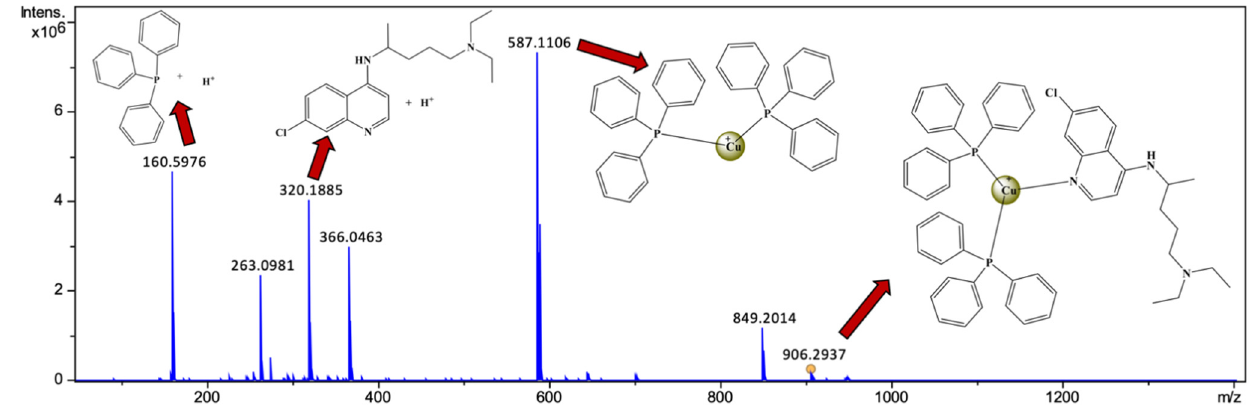
Figure 2. ESI(+)-MS spectrum of [Cu(CQ)(PPh 3 ) 2 ]NO 3 ( 1 ) in acetonitrile.